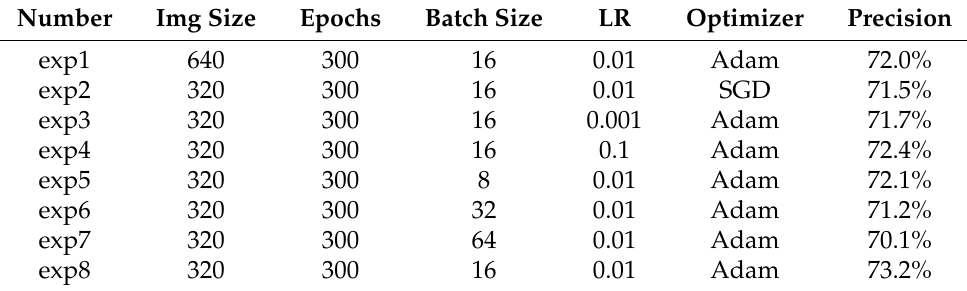
Table 3. Parameter adjustment and results.